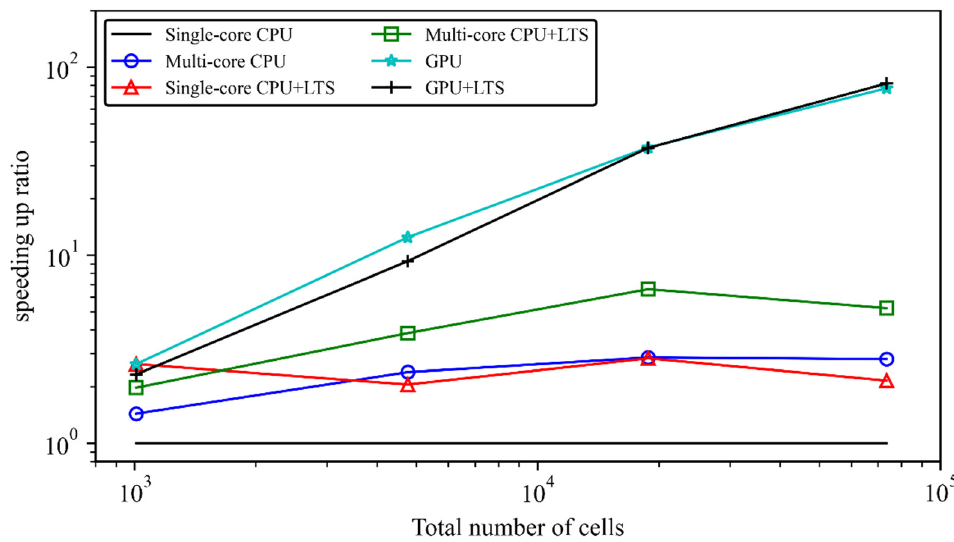
Figure 4. Speeding-up ratios of the six SWM versions for simulations of the dam break flows, as compared to the single-core CPU version.